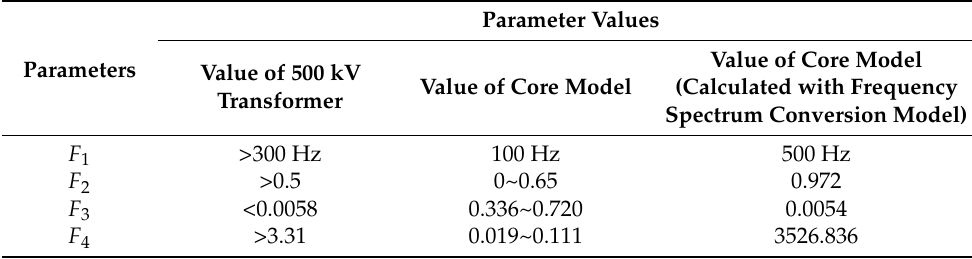
Table 2. Comparison of acoustic parameters calculation results. Parameter Values Parameters Value of 500 kV Value of Core Transformer